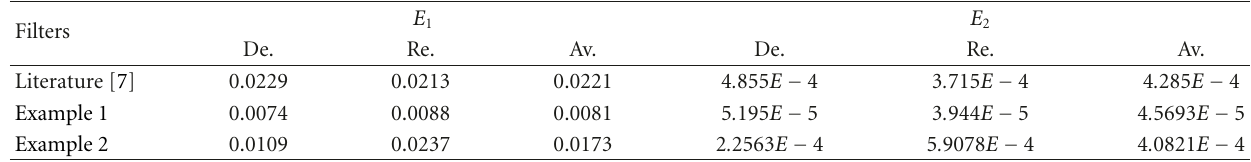
Table 2: E 1 and E 2 measures in literature [7], Example 1 and Example 2.